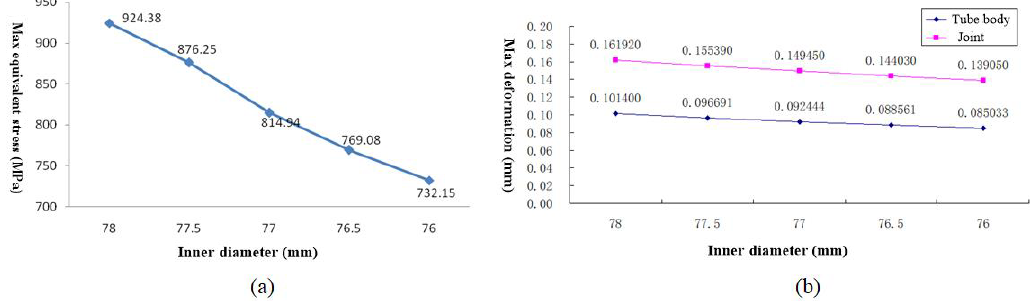
Figure 11. (a) The trend diagram of the maximum equivalent stress with inner diameter decreases; (b) the trend diagram of the maximum total deformation with inner diameter decreases.